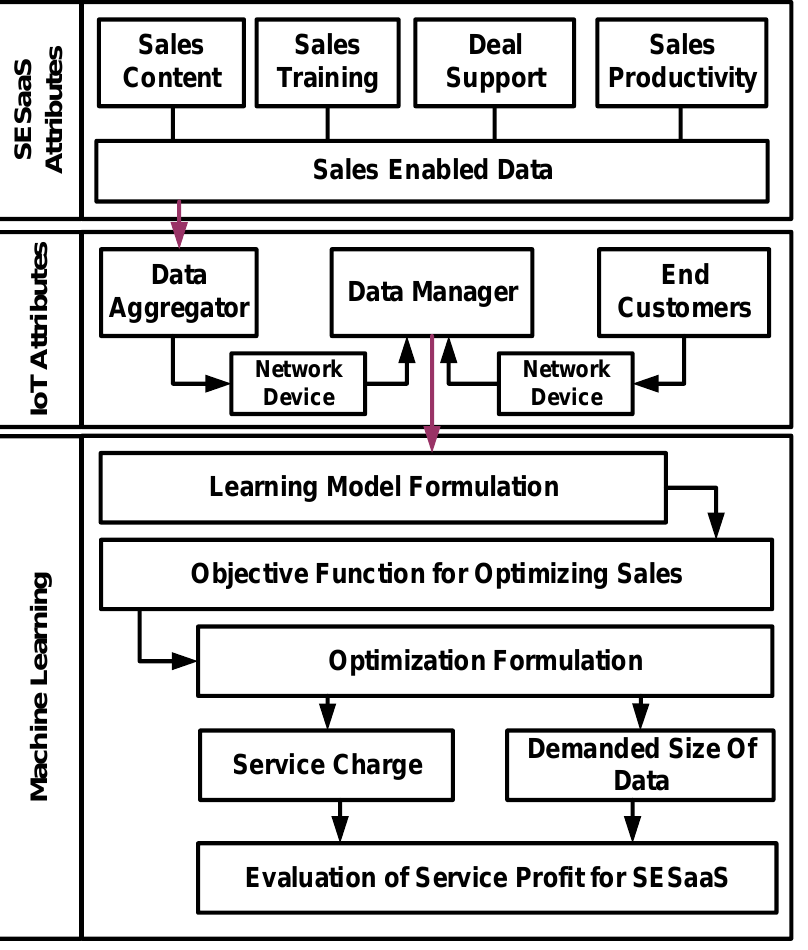
Figure 1. IoT-based SESaaS schematic diagram.